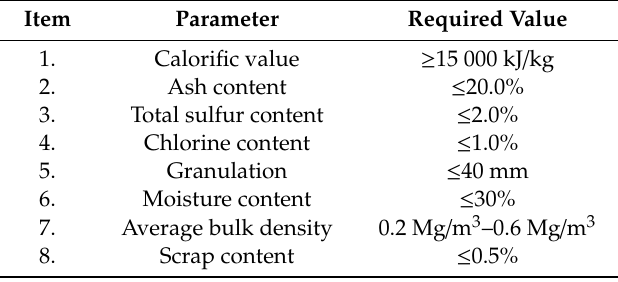
Table 1. Properties of molded fuel-values required by cement plants. Item